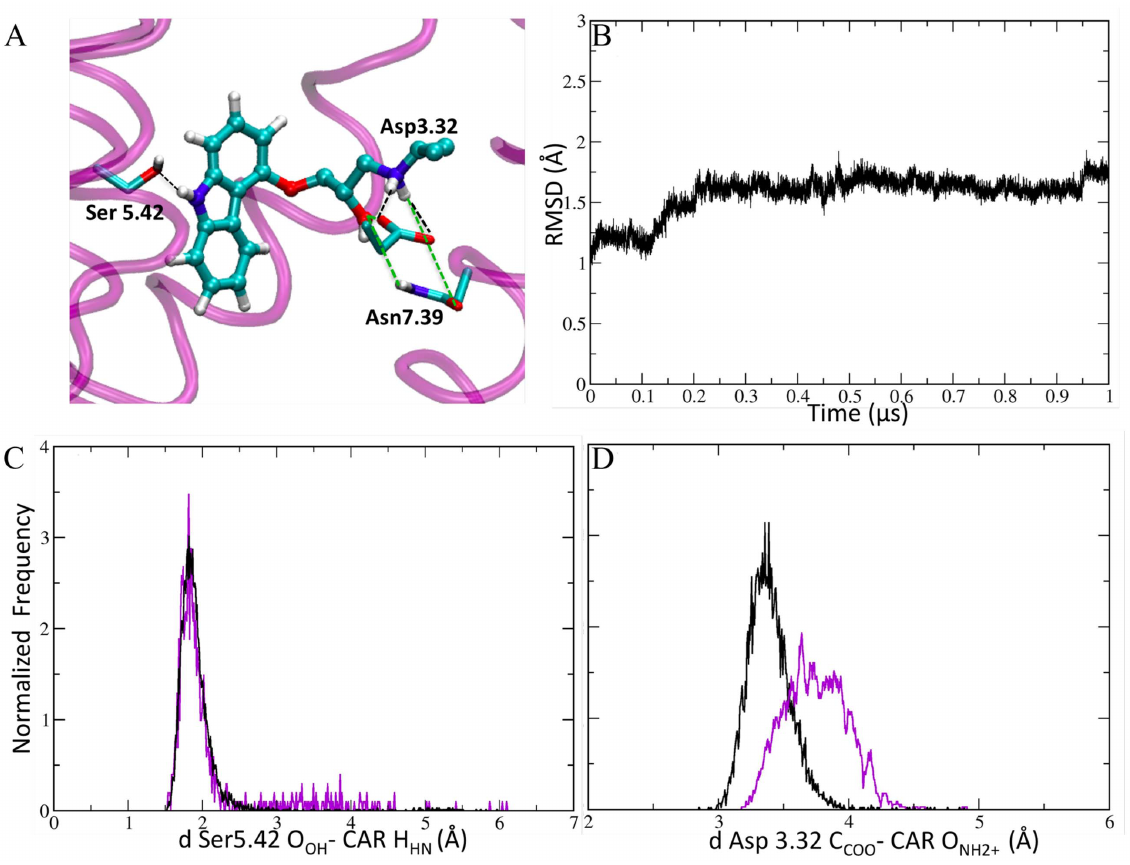
Figure 2. b 2 AR in complex with the S-Car ligand. A) S-Car binding site of the central structure of the only cluster of the MM/CG simulations. This cluster represent 100% of the conformations of the adduct. B) RMSD of the C a atoms plotted as a function of time in the MM/CG simulations. C– D) Distribution of agonist-protein H-bonds in the MM/CG simulations of the b 2 AR/S-Car complex based on the X-ray structure [14] (black line) and on an homology model (violet line, this